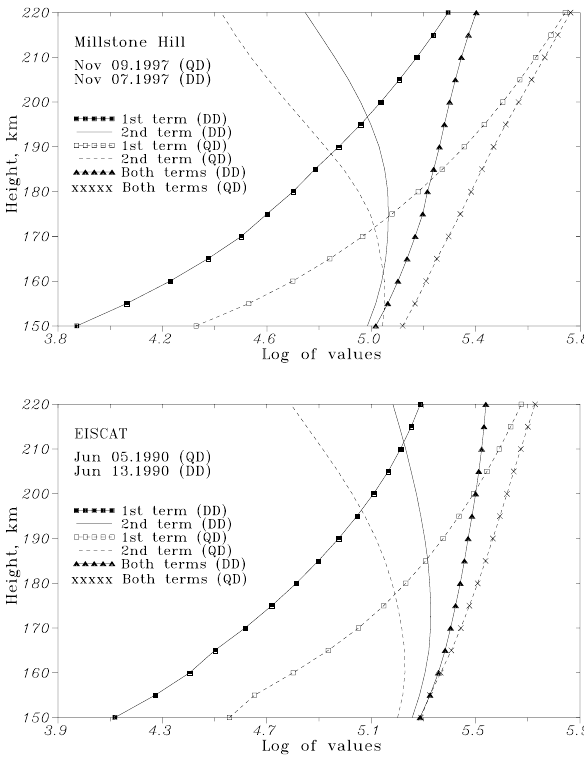
Fig. 3. Calculated distribution of atomic oxygen O + and molecular M + ions as well as their sum, Ne for winter (7 Nov/9 Nov 1997) and summer (13 Jun/5 Jun 1990) disturbances. Solid lines and filled symbols refer to the disturbed days.